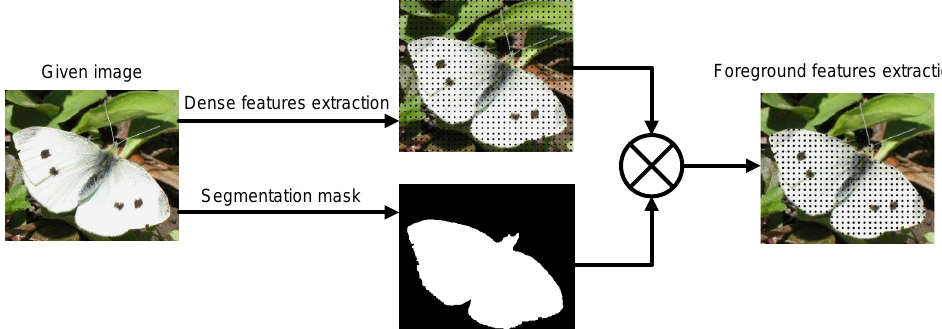
Figure 7. The process in which the segmentation masks are utilized to extract foreground features for vocabulary